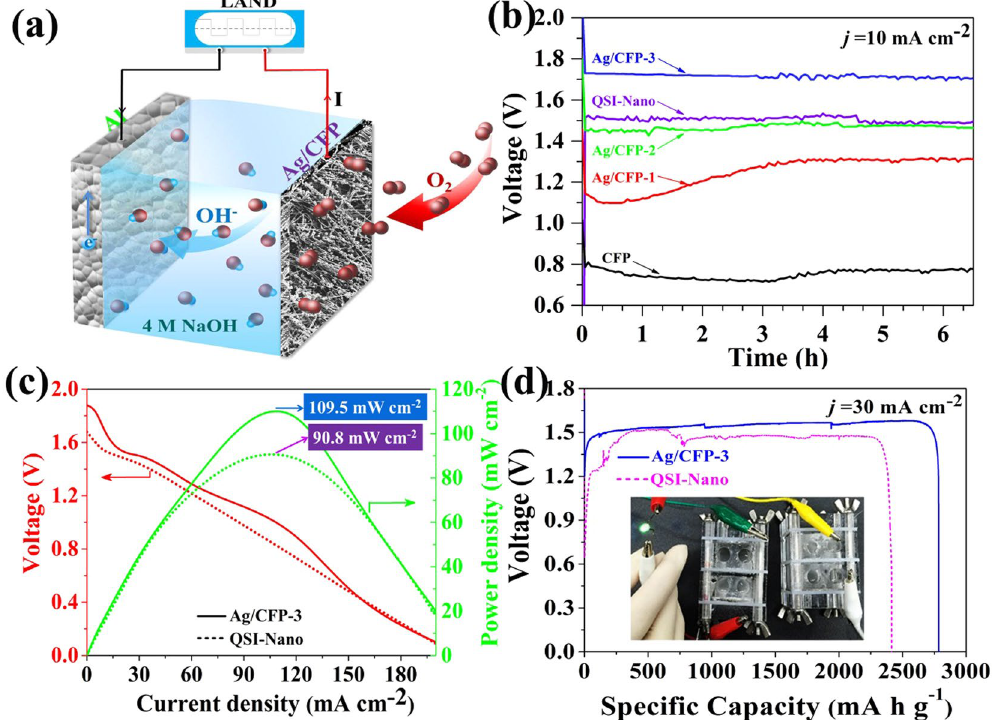
Figure 7. ( a ) A schematic of the primary Al-air battery. ( b ) Long-time discharge curves of primary batteries using bare CFP, Ag/CFP-1, Ag/CFP-2 and Ag/CFP-3 cathodes at current density of 10 mA cm − 2 compared with the battery using commercial QSI-Nano air electrode as cathode. ( c ) Polarization curve (red) and corresponding power density plot (green) of the batters using Ag/CFP-3 (solid line) and QSI-Nano electrode (dotted line) as the cathodes. ( d ) Specific capacities of the primary Al-air batteries with Ag/CFP-3 and QSI-Nano electrode as the cathodes at the current density of 30 mA cm − 2 , which were normalized to the mass of the consumed Al. The inset shows a photograph of a green LED ( ≈ 3.0 V) powered by two liquid Al-air batteries with the Ag/CFP-3 air cathode connected in series.